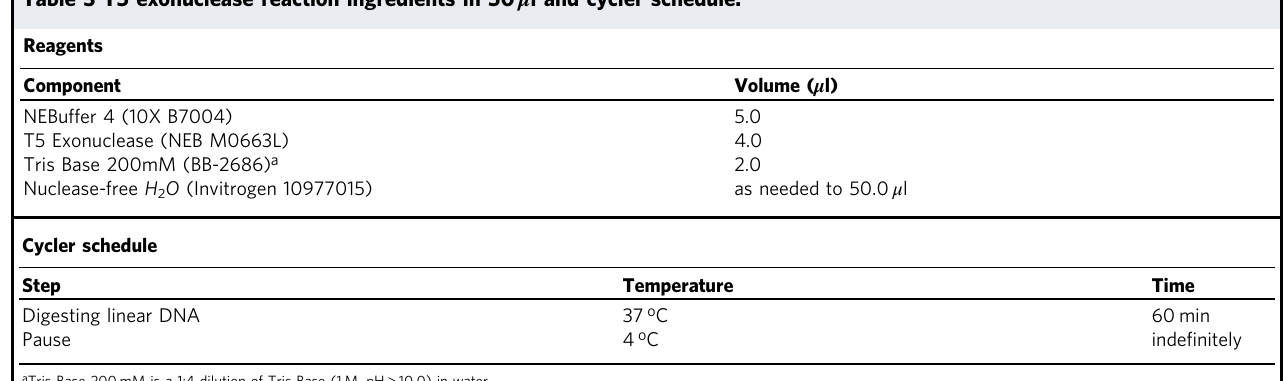
Table 3 T5 exonuclease reaction ingredients in 50 μ l and cycler